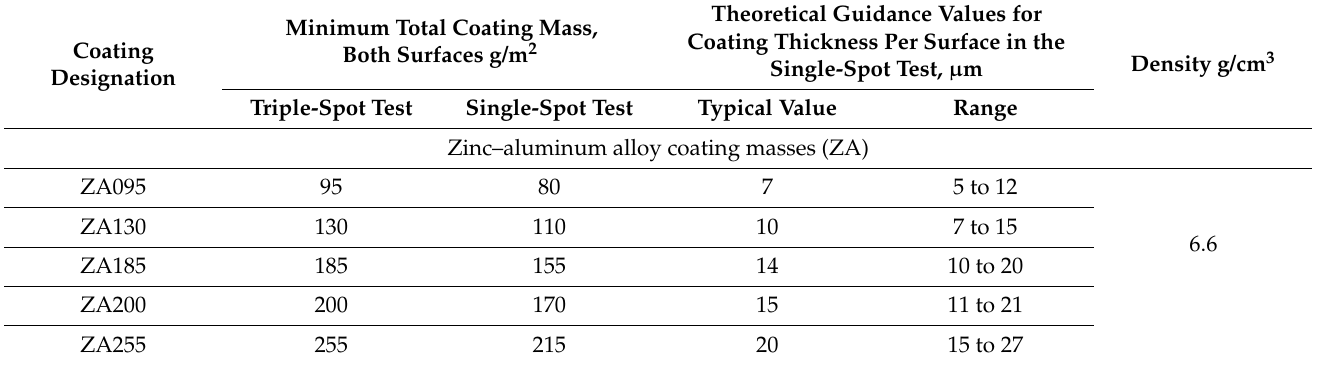
Table 1. Selected physical properties of the research